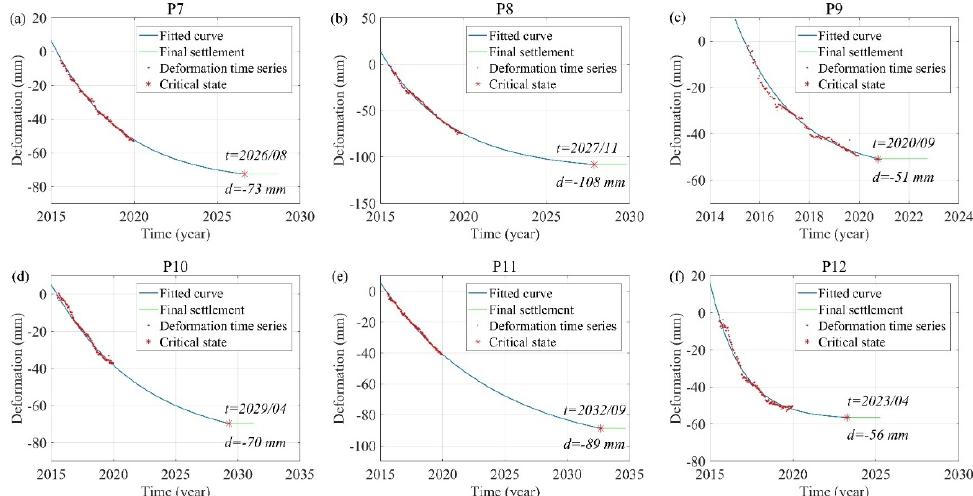
Figure 10. Predicted settlement curves of ( a ) P7, ( b ) P8, ( c ) P9, ( d ) P10, ( e ) P11 and ( f ) P12. Locations of points P7 − P12 are shown in Figure A2. t is the consolidation time, and d is the final settlement.